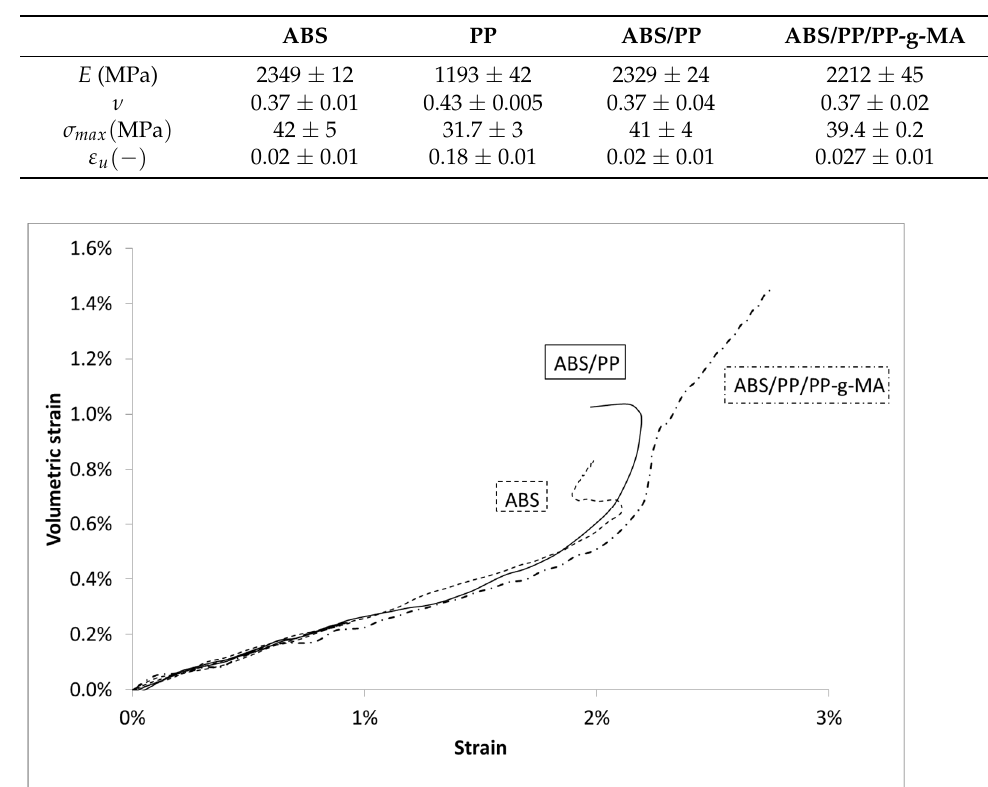
Figure 6. Volumetric Strain vs. Lagrangian strain in uniaxial tensile tests at 10 mm/min for ABS, PP, and composites.